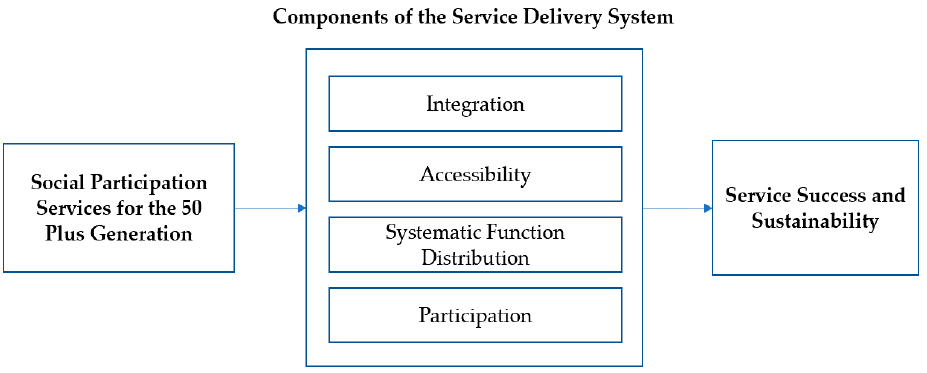
Figure 2. Conceptual research model.